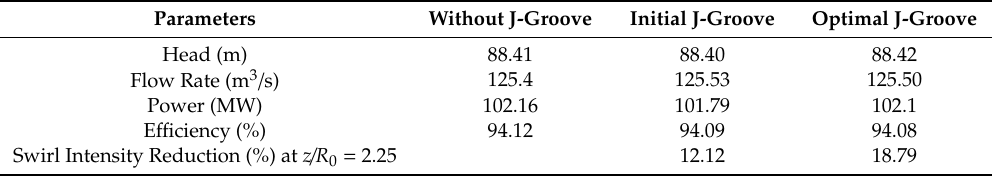
Table 12. Summary of draft tube shape optimization results for the 100 MW class Francis